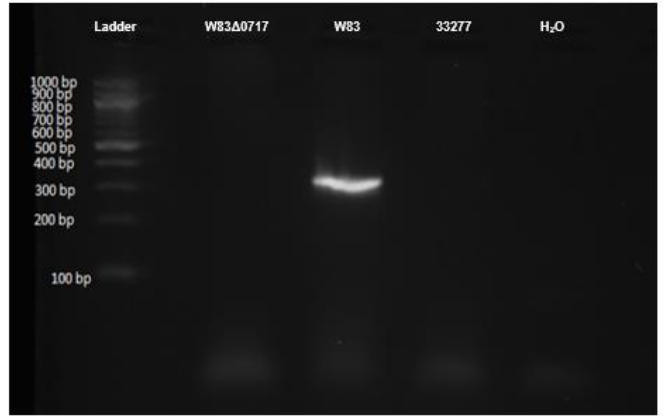
Figure 7. Image of gel electrophoresis after PCR for the PG0717 gene in P. gingivalis W83, 33,227, and W83 W83 ∆ 0717 mutant. H 2 O represents “no template” control. PCR product is expected to be 331 base pairs.